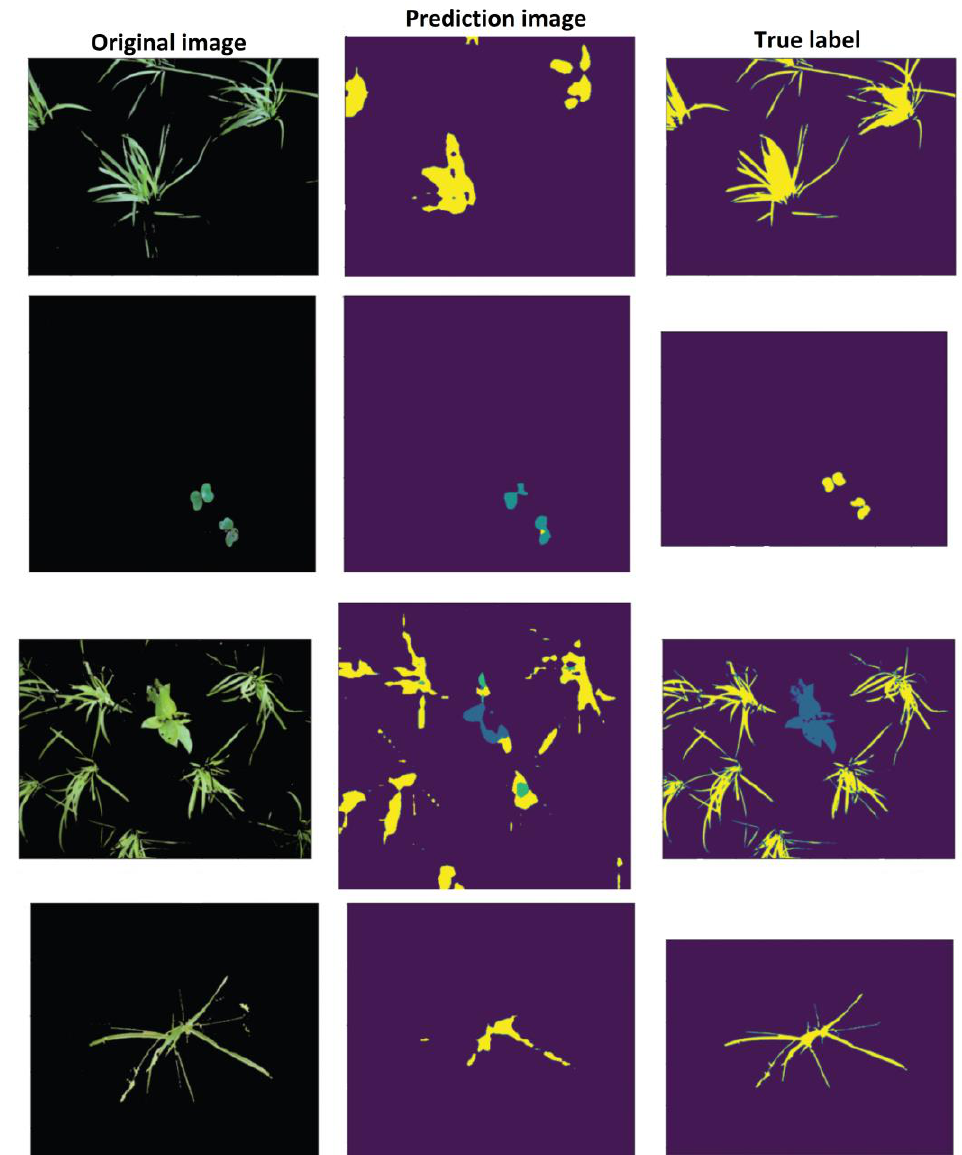
Figure 7. The results of PSPNet, the images of the first row, correspond to the original images, while the second row represents the predicted output, and the last is the ground truth image. The first line is the paddy, the second one is the broadleaved weed, the third one is the broadleaved weed (blue) and paddy (yellow), and the last, is the sedge weed, (adapted from [30]).